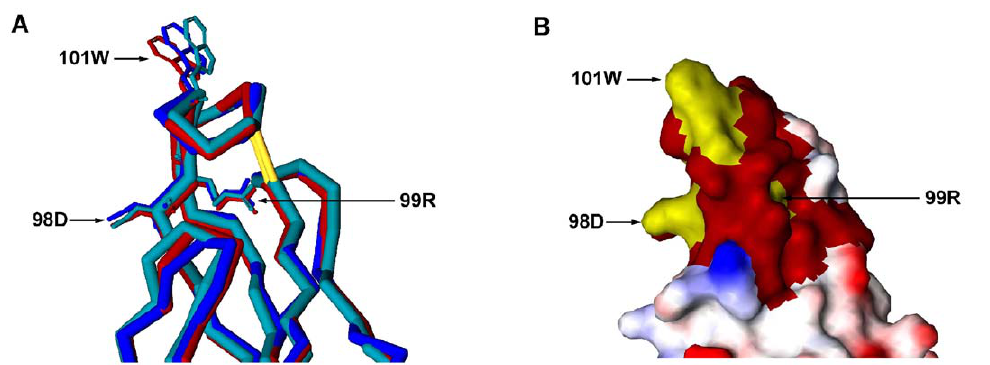
Figure 3. Structural mapping of the 2A10G6 epitope. A. the structure of the 2A10G6 epitope in the crystal structure of DENV2 E protein. Residue numbering is based on the E gene sequences. The regions in red are thought to be structurally near these three residues. B. Three- dimensional comparisons of the 2A10G6 epitope in the three known crystal structures. DENV2, WNV, and TBEV E proteins are in shades of red, blue, and cyan, respectively.